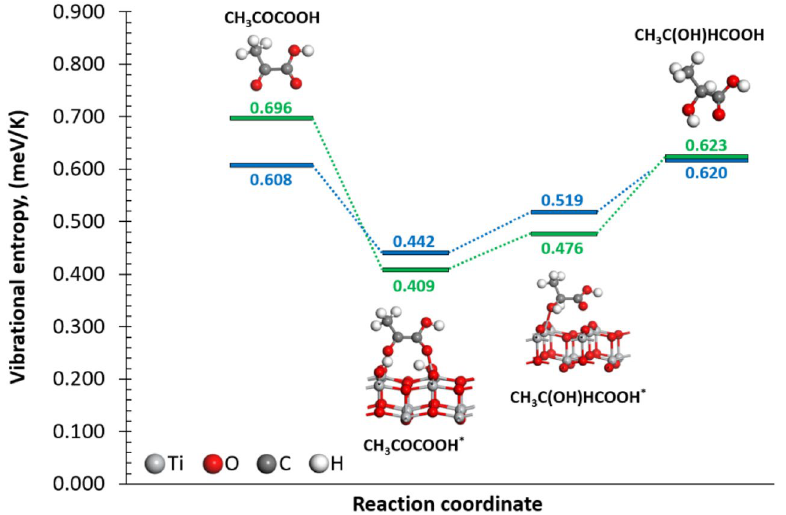
Figure 3. Vibrational entropies of the isolated and adsorbed pyruvic and lactic acid molecules. The green and blue paths correspond to the entropies without and with solvent effects,